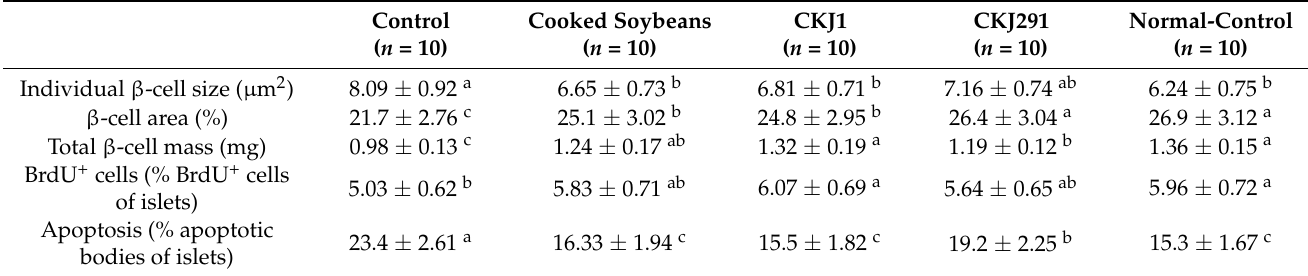
Table 5. Pancreatic β -cell mass.